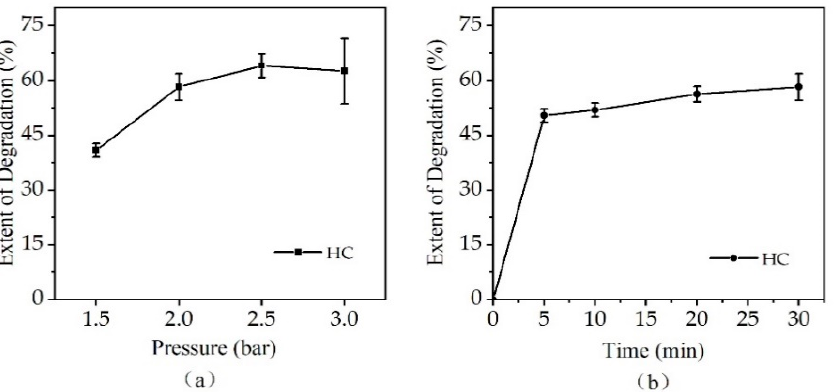
Figure 3. Effect of inlet pressure on extent of degradation of CTC by HC within 30 min: ( a ) effect of inlet pressure within 30 min; ( b ) extent of degradation of CTC by HC with 2.0 bar.